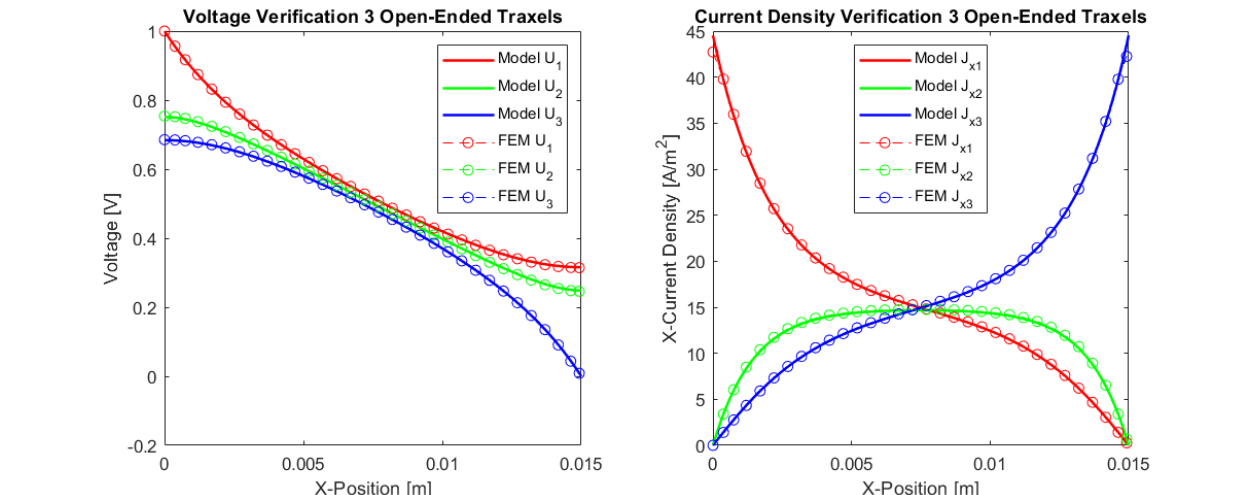
Figure 12. Comparison between the model and simulations of the dc voltage and current density in x -direction in the traxels of a sample with three traxels with open ends. The parameters shown in Table 2 are used and the number of traxels, N = 3, and inter-traxel resistance, σ = 2 × 10 − 2 Ω m 2 , are changed. The total resistance from the model is 140.3k Ω , which gives an error of 0.53% with the FEM simulation.